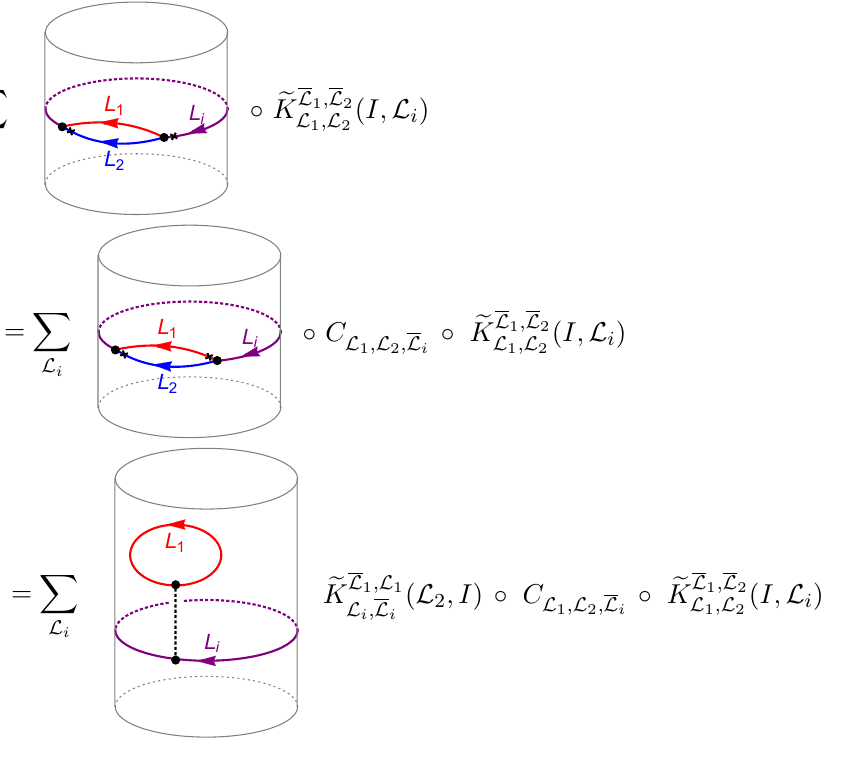
Figure 63 . Some steps in the derivation of the fusion